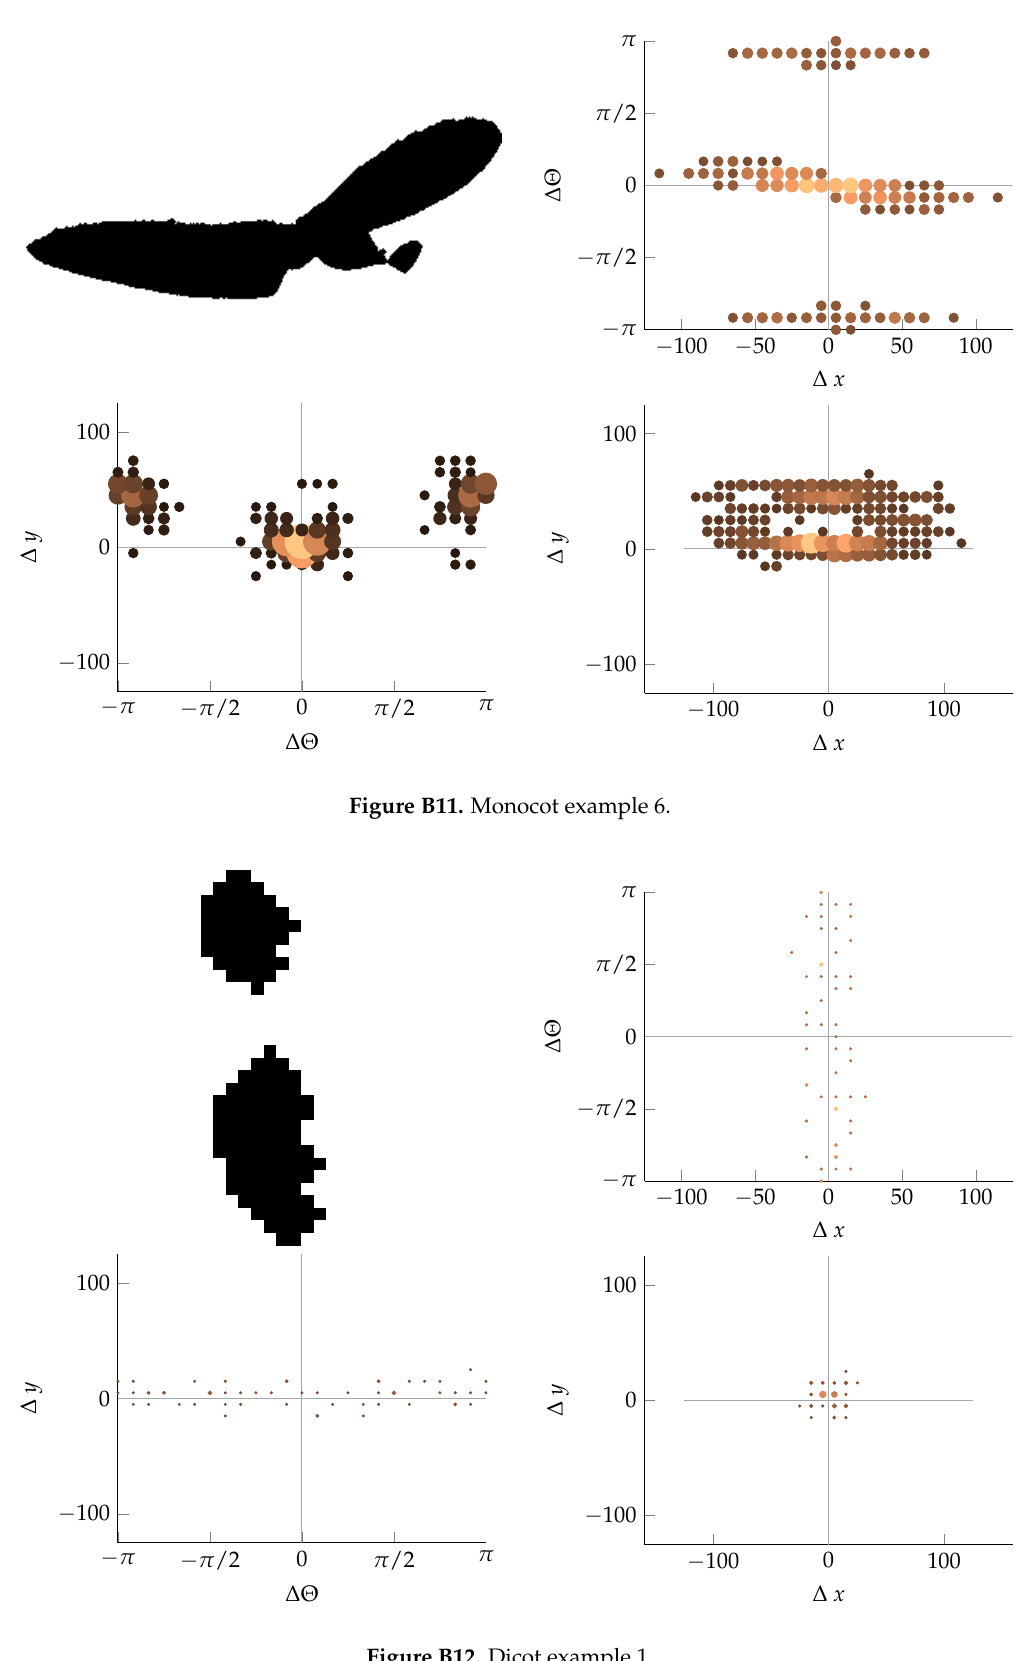
Figure B12. Dicot example